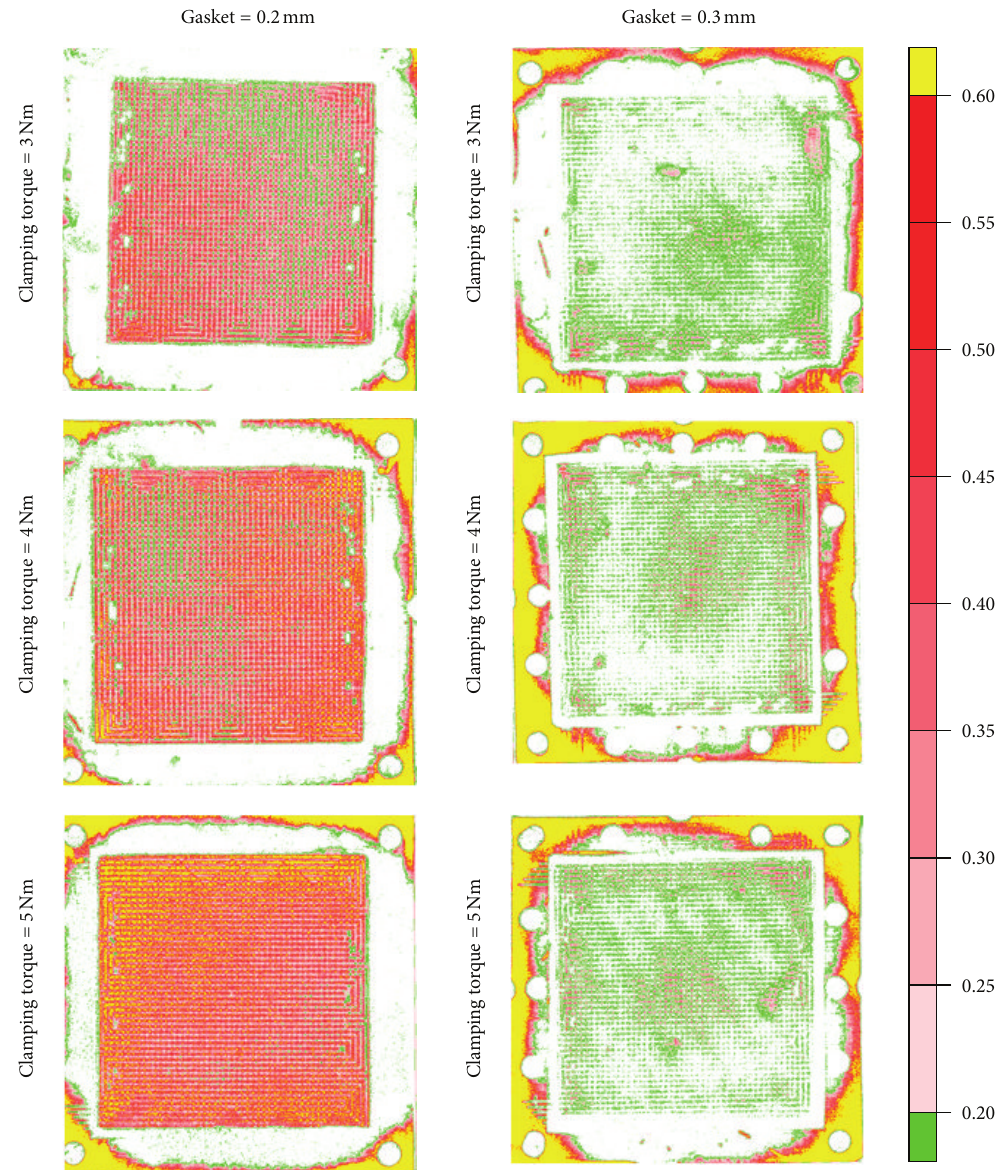
Figure 5: Contact pressure distribution (MPa) between GDL and BPP for different